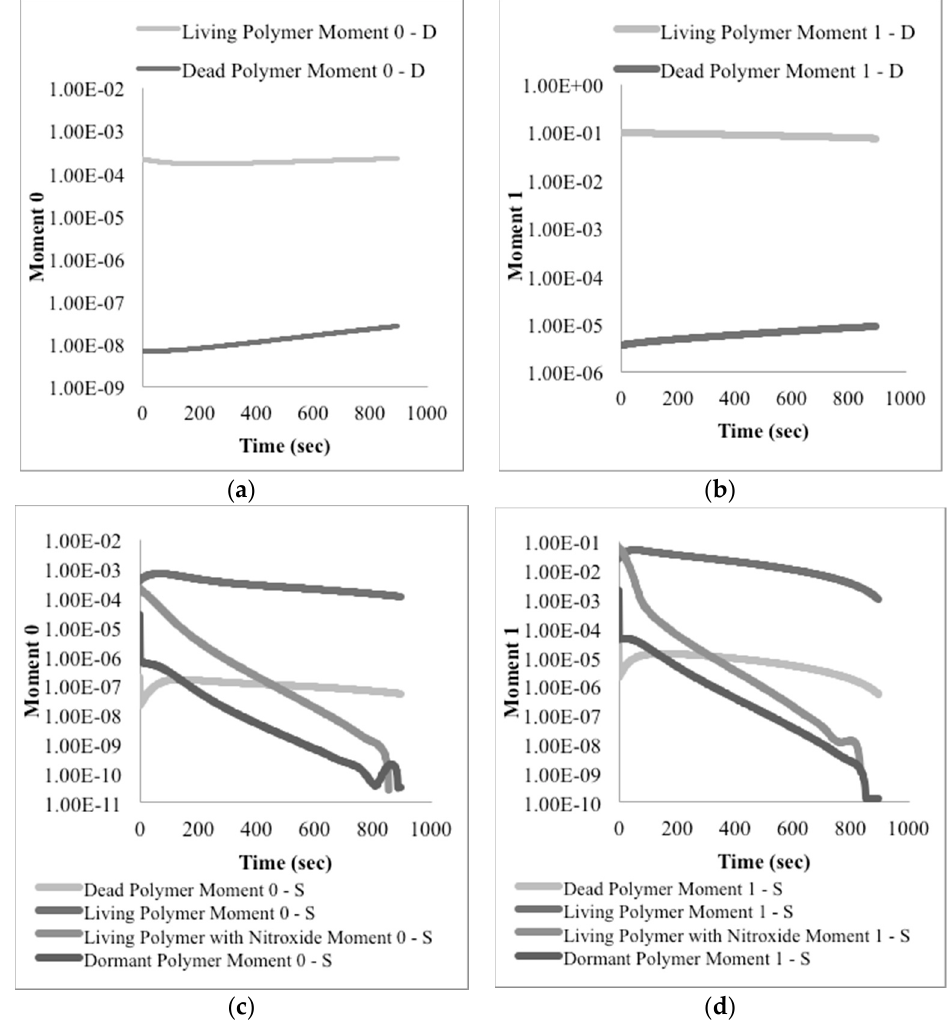
Figure 13. Model predictions for ( a ) zero-th moment evolution and ( b ) first moment evolution of live and dead polymer for the pyrolysis of dead PS. Also, model predictions for ( c ) zero-th moment evolution and ( d ) first moment evolution of live, dead, dormant, and live with a nitroxide-end polymer starting from dormant PS.